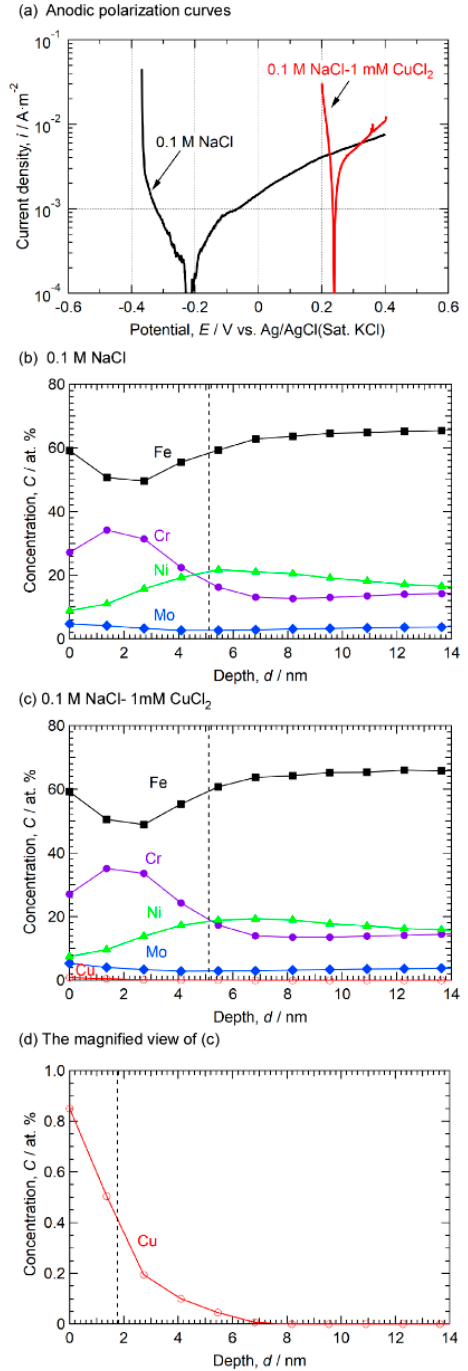
Figure 5. ( a ) Anodic polarization curves polarized to 0.40 V in 0.1 M NaCl and 0.1 M NaCl-1 mM CuCl 2 . Composition depth profiles of the surfaces for the specimens polarized ( b ) in 0.1 M NaCl and ( c ) in 0.1 M NaCl-1 mM CuCl 2 . ( d ) Magnified view of ( c ).